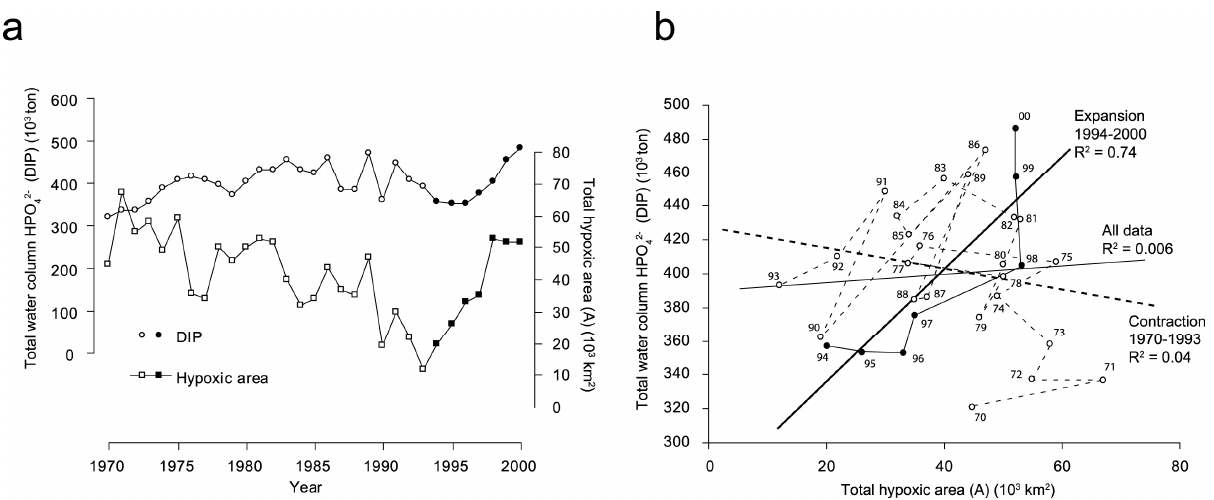
Fig. 6. (a) Time series of total hypoxic area of the Baltic (“A”, square symbols), i.e. the area of sediments in contact with bottom waters of < 2mlL − 1 O 2 , and the total pool of dissolved inorganic phosphate (DIP, circles). Both series averaged for January-March for each year from 1970–2000 (data from Table 1 in Conley et al., 2002). Open symbols indicate 1970–1993 “contraction” of hypoxic area, closed symbols represent 1994–2000 “expansion” phase. (b) Cross-plot of the same data. Trend for complete dataset shown as a fine solid line. Data points for 1970–1993 (open circles) are joined chronologically with a dashed line. Note the frequently positive relationship between annual changes in A and DIP but the overall negative trend for this interval (dashed trendline). Data points for 1994–2000 (filled circles) are joined chronologically with a solid line (heavy solid trendline represents 1994–2000 trend).